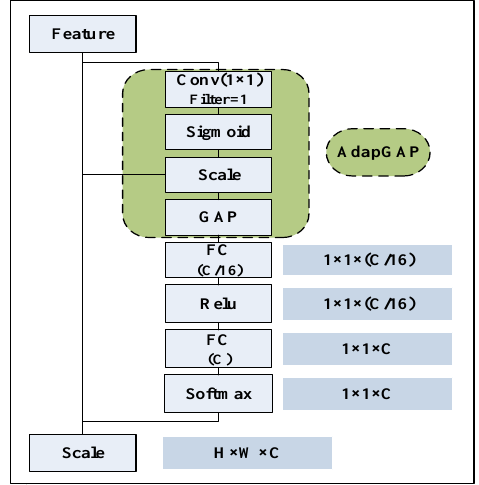
Figure 3. Structure of AdaSE.